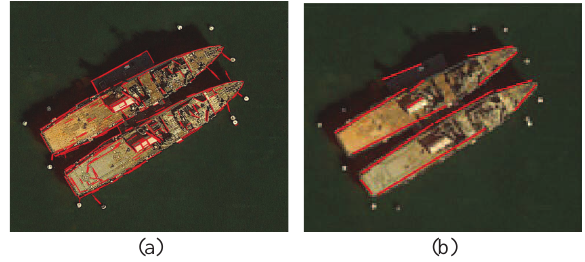
Figure 5: An illustration of line segments extracted from a warship image in different resolutions: (a) in the original resolution; (b) in the low resolution with a down-sampling scale factor of